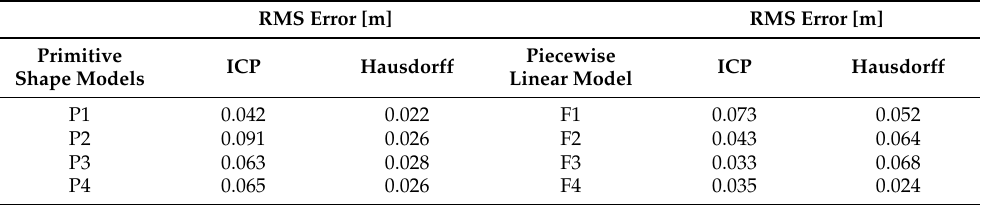
Table 2. RMS localization error for each type of landmark found by the genetic algorithm.